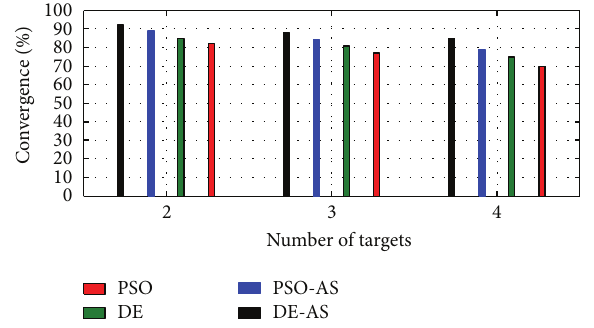
Figure 5: Convergence versus number of targets.